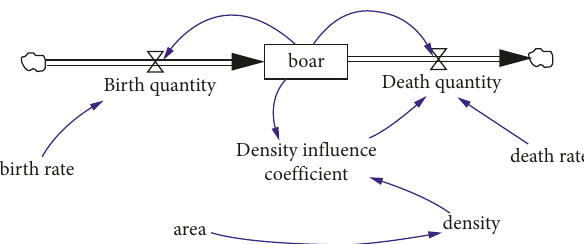
Figure 2: Feedback diagram of a system dynamics model of a wild boar